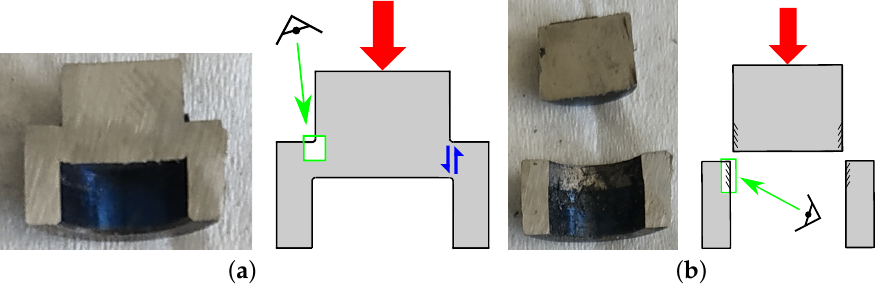
Figure 6. Axial cut of hat-shaped specimen: ( a ) case without failure and ( b ) case after